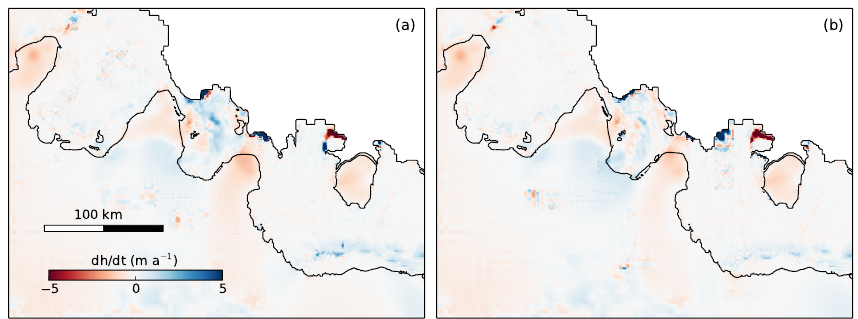
Figure 2. Surface elevation change rates after relaxation of B e /S and B e /U (a) and RF/S (b) initialisations, for linear sliding. Table 2. Set-up of all 36 experiments. The name of each experiment reflects the dataset used for initialisation, its initial ice/bed geometry, the form of sliding law, and the type and amplitude of the melt rates. Dataset for Sub-ice-shelf melt